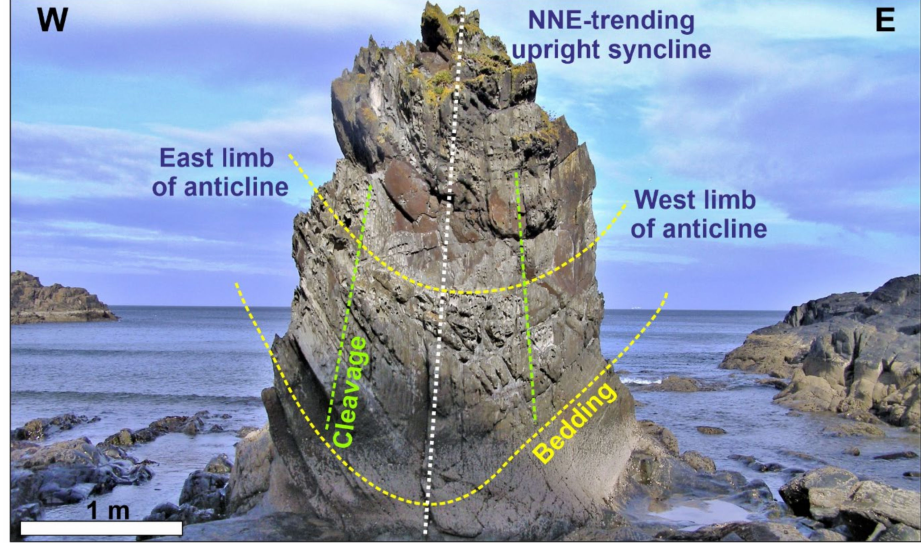
Figure 8. Field photograph of a NNE-trending upright synform that folds bedding (highlighted in yel- low) and develops a broadly axial-planar cleavage (in green). (Macduff area: UK Grid: NJ7190